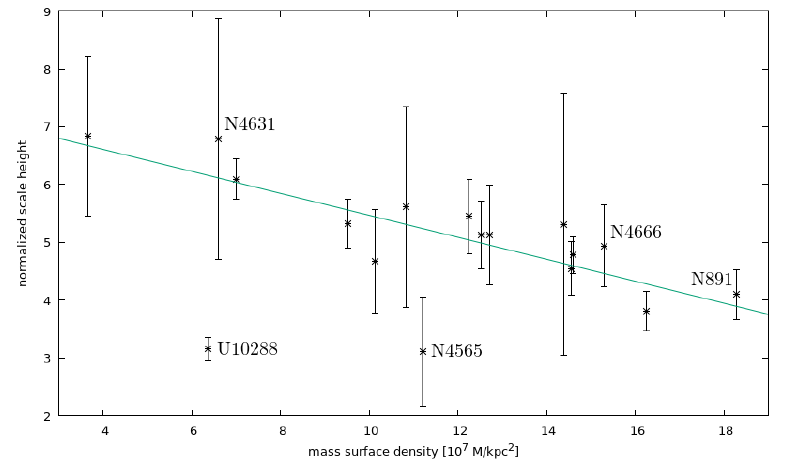
Figure 6. The normalized scale heights anti-correlate with the mass surface densities for the galaxies of the sample of Krause et al. [55], as well as for NGC 4666 [40], NGC 4631 [30], and NGC 891 [39]. The outliers (NGC 4565 and UGC 10288) have a significantly lower total magnetic field strength of only 6 µ ≈